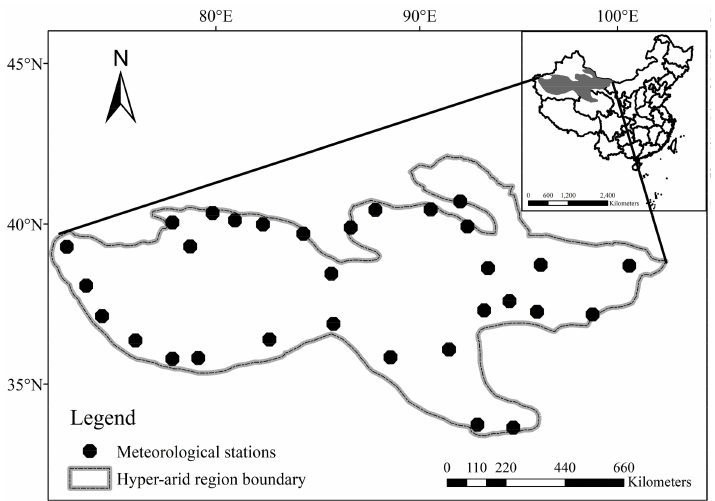
Figure 1. The location of the meteorological stations in the study area. Gray area indicate the location of hyper-arid region in China.